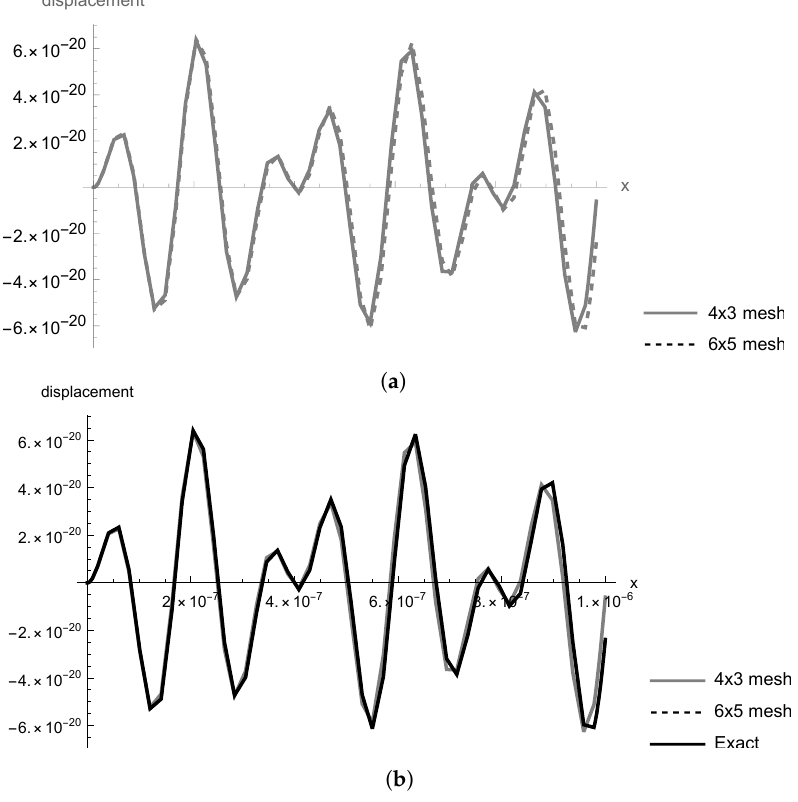
Figure 2. Comparison of the numerical time histories of the displacement function at the point ( L X ) . ( a ) Comparison between the results for 4 × 3 and 6 × 5 meshes. ( b ) Comparison between , L Y 2 3 the results for 4 × 3 and 6 × 5 meshes with the exact